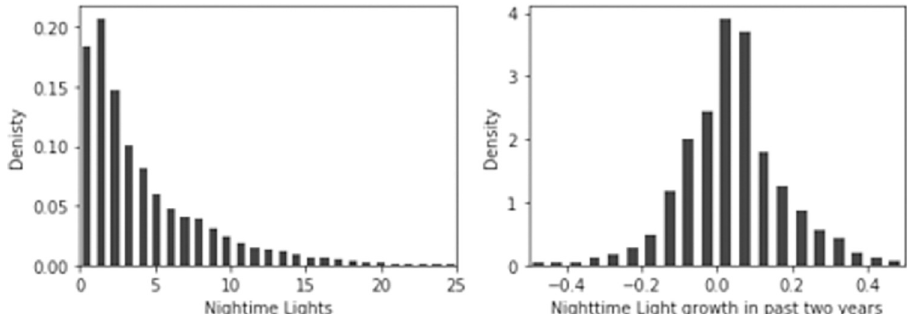
Fig 4. Distribution of local night-time light and growth. Note : Own calculations based on NOAA data and 50km radius around each DHS cluster. Larger values reflect more illuminated areas with a possible range of 0-63.